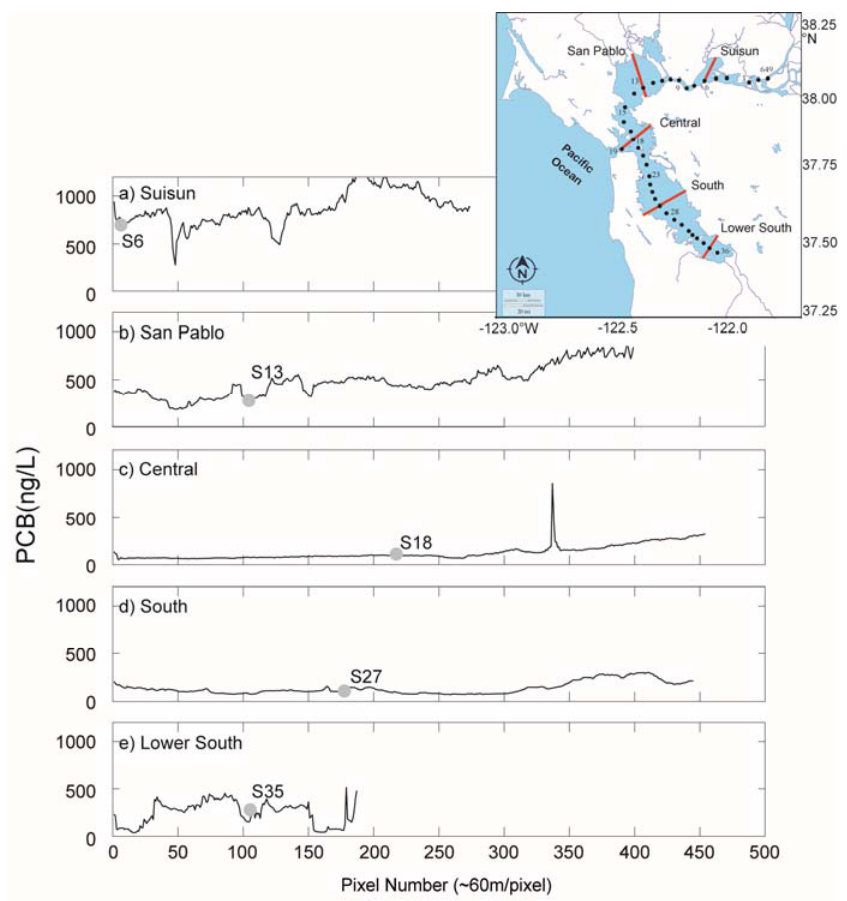
Figure 5. To illustrate the cross ‐ shelf variability that is not captured by traditional sampling, PCB concentration was estimated from 26 May 2016 OLI image using the entire ‐ bay model with zero intercept (Table 1). Panels ( a – e ) indicate estimated cross ‐ shelf PCB variability (solid black lines) along cross ‐ shelf transects located in ( a ) Suisun, ( b ) San Pablo, ( c ) Central, ( d ) South, and ( e ) Lower South Bay. Grey circles indicate PCB concentrations estimated from UCBS ‐ measured SSC, which spatially correspond with transects. Transect locations are indicated as red lines on the inset map (upper right ‐ hand corner).